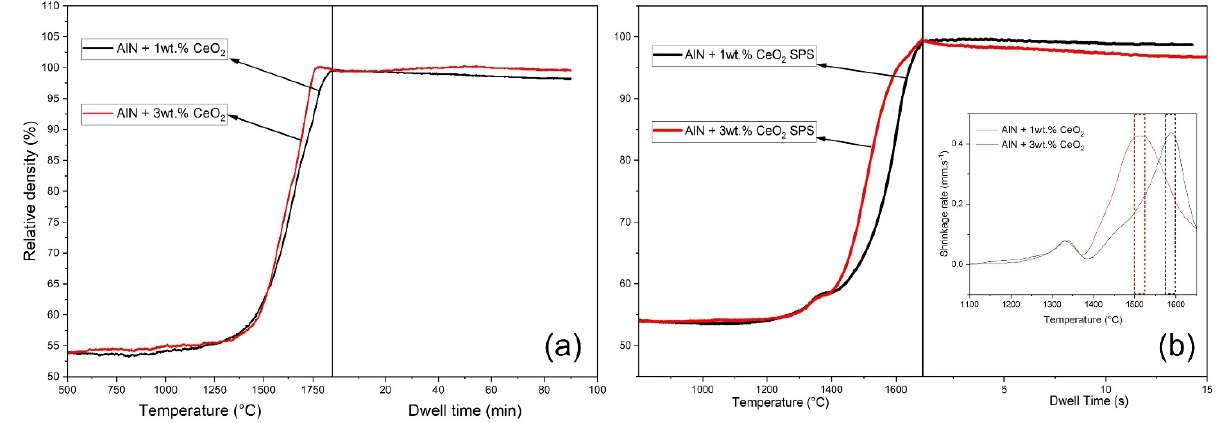
Figure 7. Sintering curves of samples with 1 wt.% and 3 wt.% obtained by ( a ) hot-pressing and ( b ) spark plasma sintering. Table 2. Distinctives temperatures of ceramics obtained by both HP and SPS.